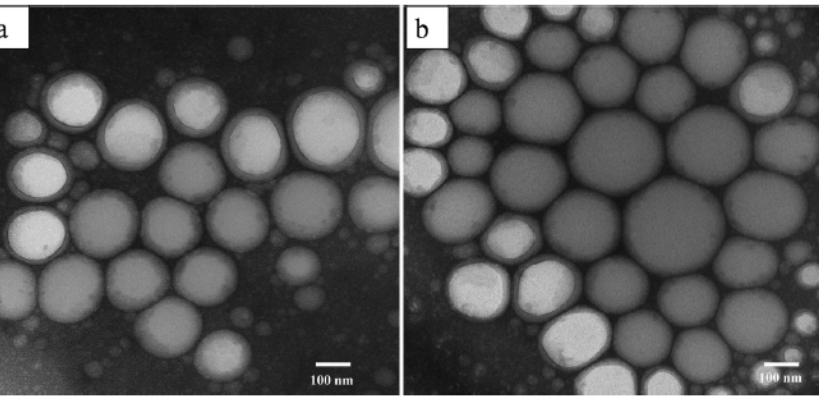
Figure 7. TEM images of the best nanoemulsions without quercetin ( a ); TEM images of the best Q-SNEDDS nanoemulsions at 72 h after Q-SNEDDS dilution ( b ) [44]. “Reproduced with permission from reference”.